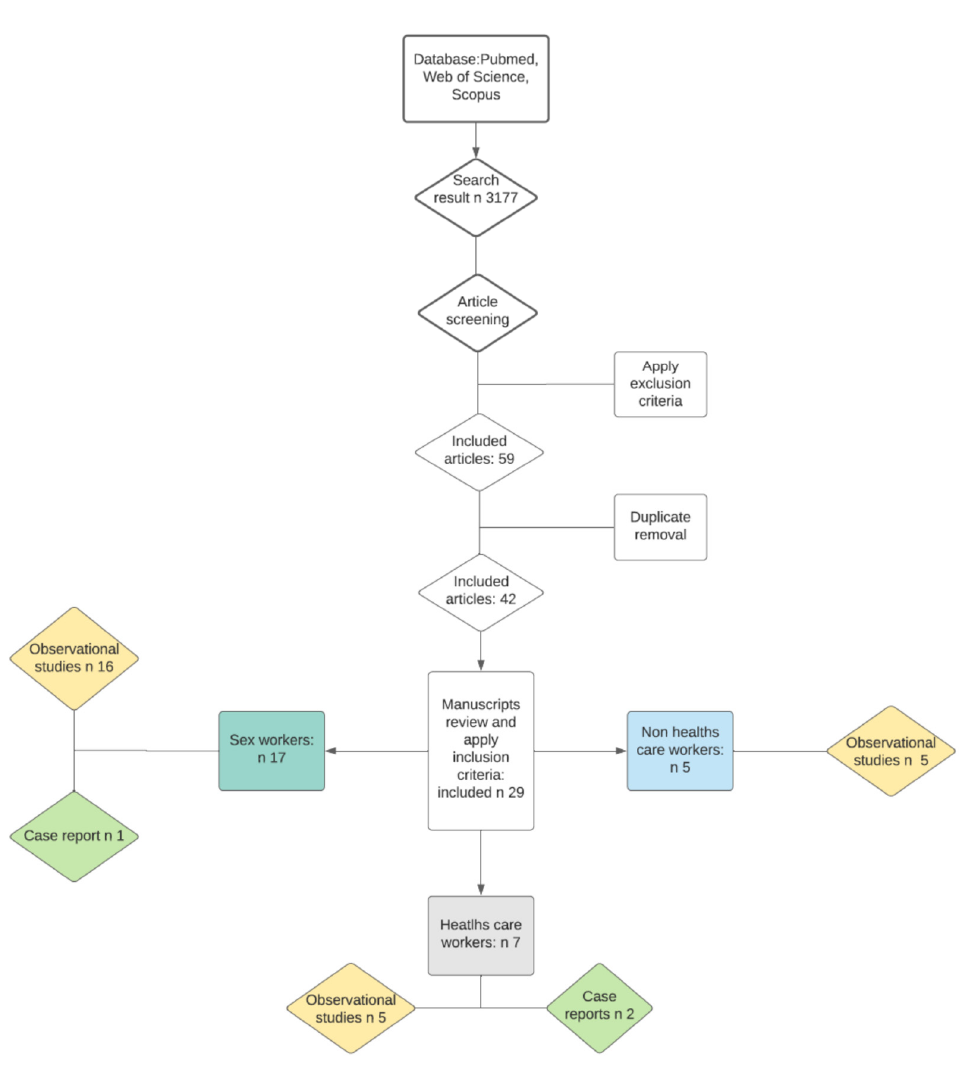
Figure 1. Description of the selection process for articles included in the review (PRISMA method).